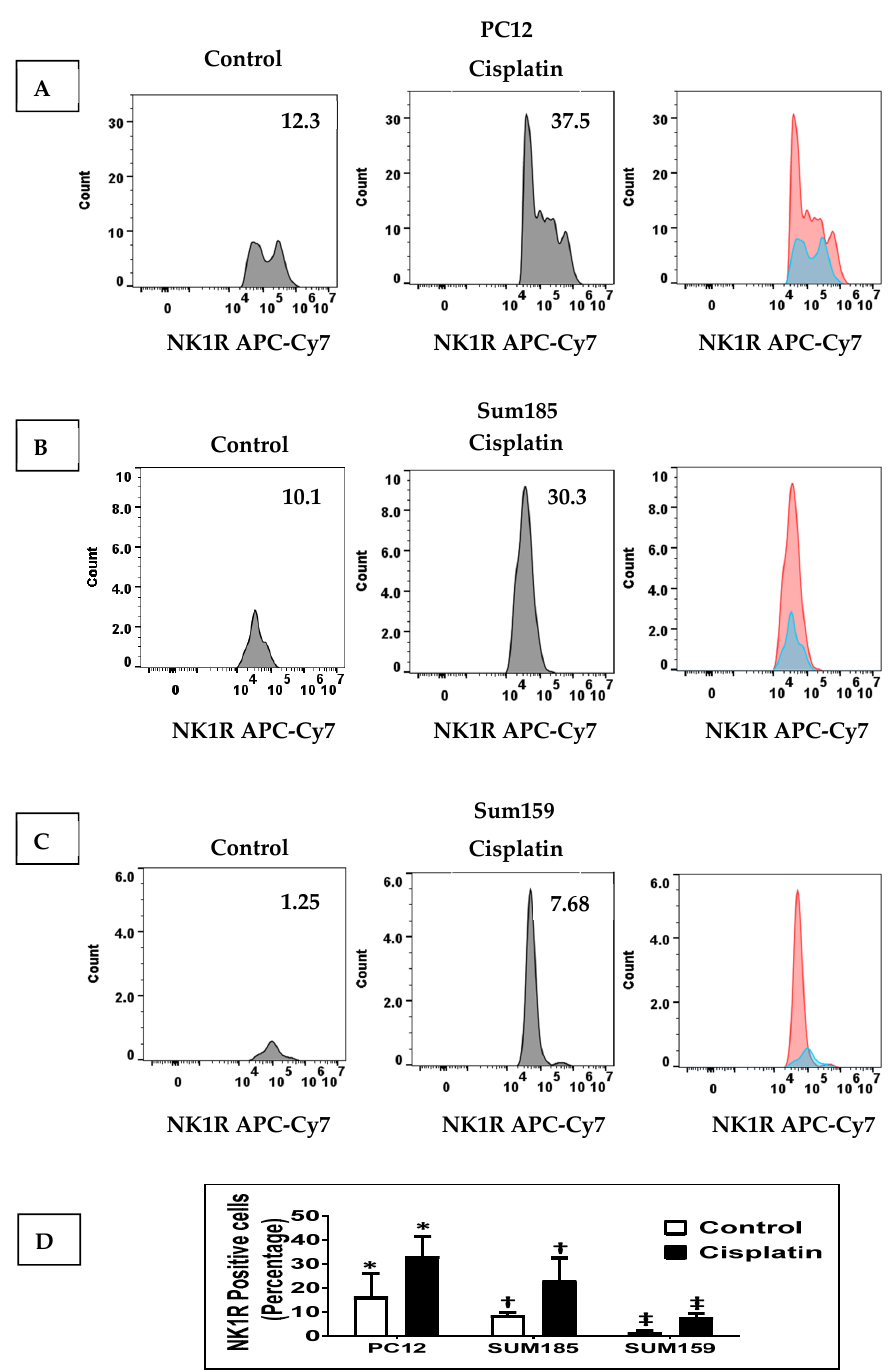
Figure 1. Cisplatin increases NK1R Levels in both PC12 neuronal cells and TNBC Cells. NK1R positive cells as determined by flow cytometry, in cisplatin-treated versus untreated PC12 cells, Sum 185 and Sum 159 cells ( A–C ), gate and numbers represent NK1R positive population within live cells. Levels of NK1R positive cells in all three cells ( D ) ( * , †, ‡, p ≤ 0.05, Student’s t -test, n = 2).